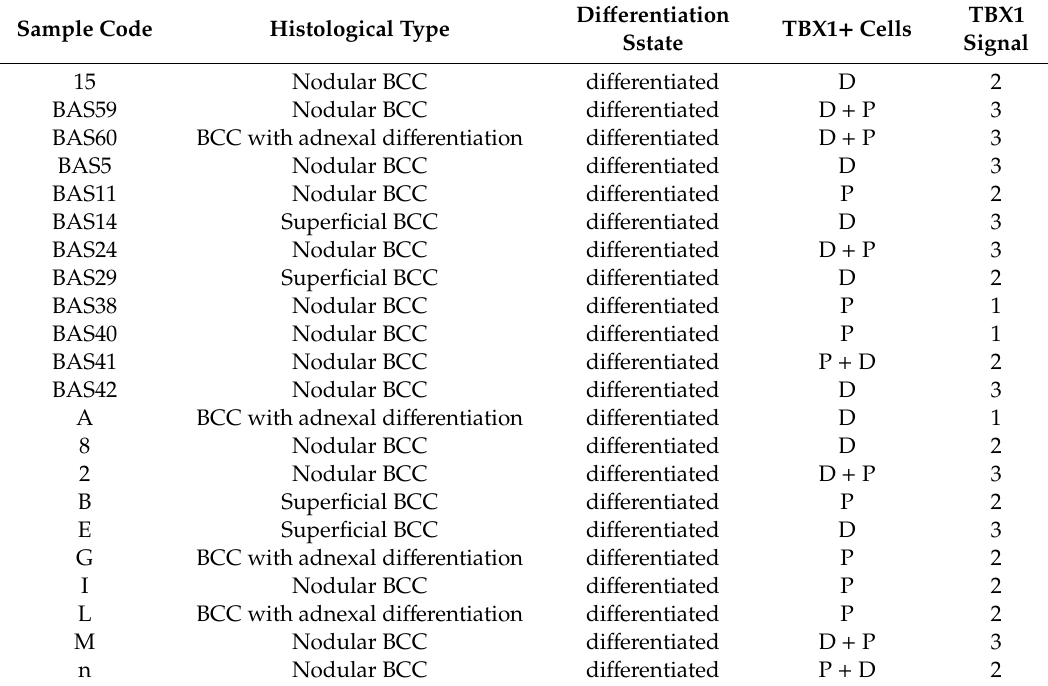
Figure 3. Immunofluorescence examples of section from BCC cases with aggressive growth. TBX1 in green, Ki67 (a marker of cell proliferation), in red, and DAPI in blue. ( A ) Case with a polarized distribution (i.e., mostly limited to the periphery of BCC) and ( B ) with a di ff use distribution. ( C , C (cid:48) ), two regions of the same tumor with di ff erent distribution of TBX1 + cells. Scale bar is 100 µ m. See Figure S1 for examples of hematoxylin-eosin staining of these biopsies. Table 3. Results of TBX1 immunofluorescence